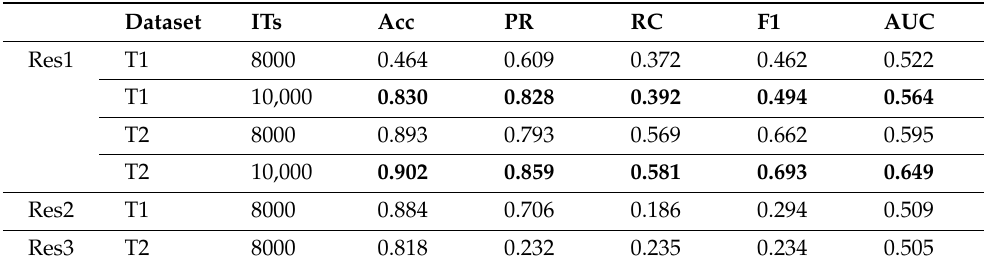
Table 2. Performance summary of ResNet models trained different on training data versions. Note: Number of training instances (ITs), ResNet models trained on custom and synthetic data, custom and Random noise data, custom and Gaussian noise data noted as Res1, Res2 and Res3, respectively, and the bold scores indicate the highest mean scores obtained in test phase.